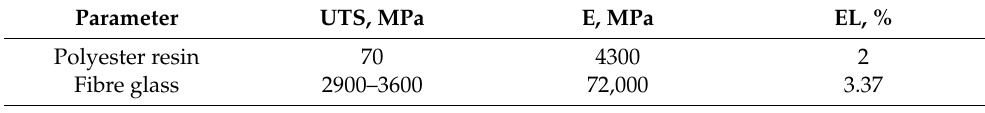
Table 1. Properties of resin and reinforcement used in the manufacturing process.